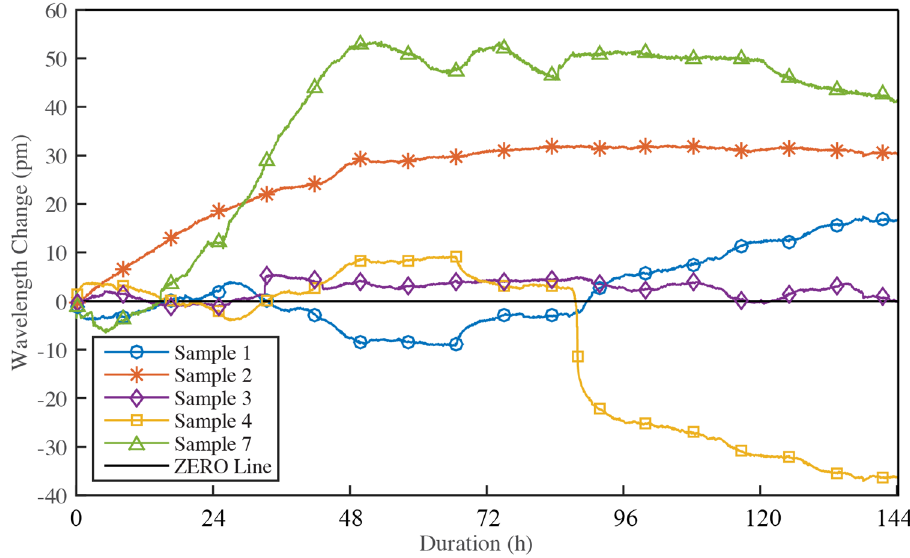
Figure 13. Temperature compensated Bragg wavelength changes of embedded FBG sensors with test time.